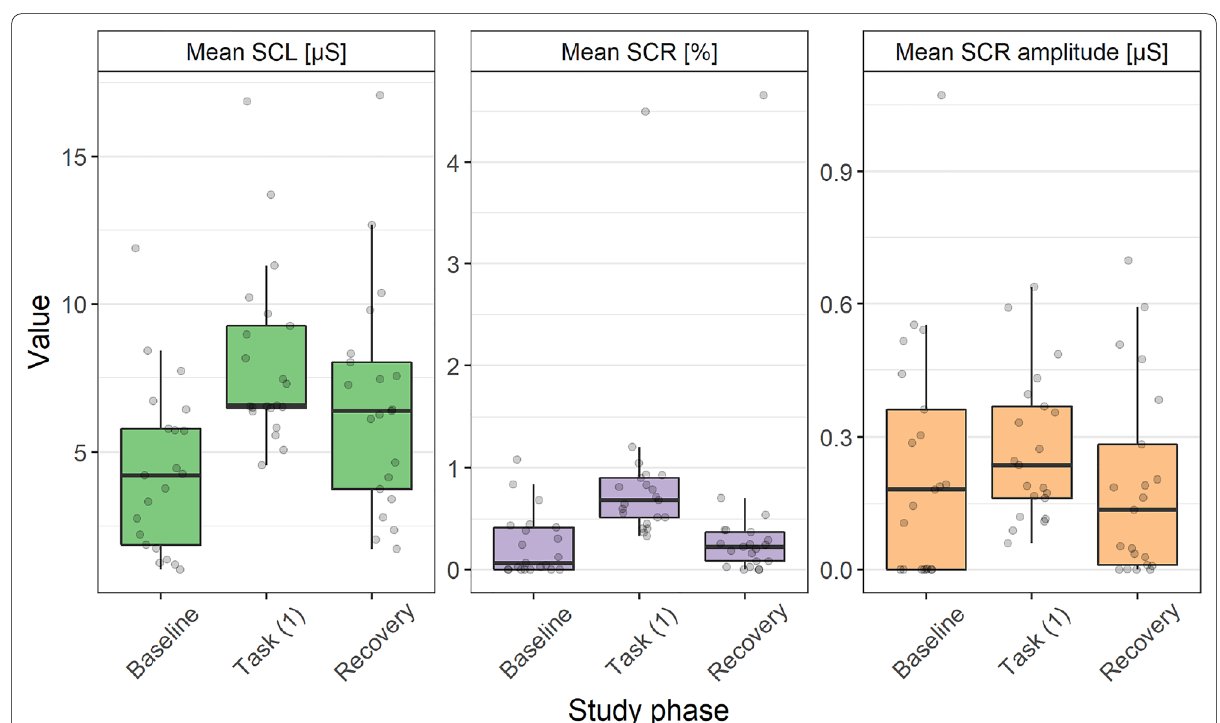
Fig. 6 Electrodermal activity throughout study